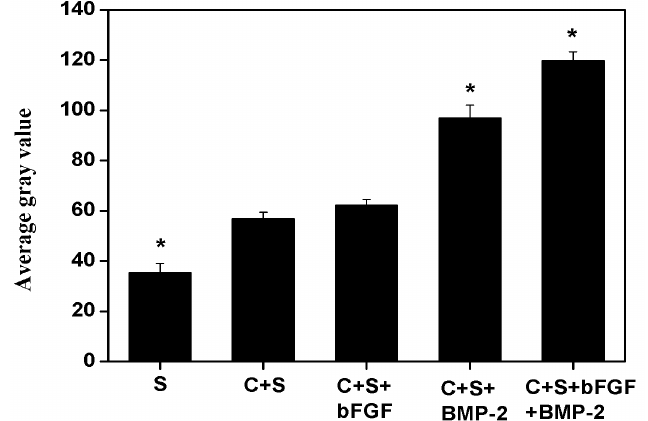
Figure 9. The analysis of new bone density of large-sized mandibular defects repaired using different implants shown at week 12 post-implantation. (Mean ± SD; n = 3; * p <